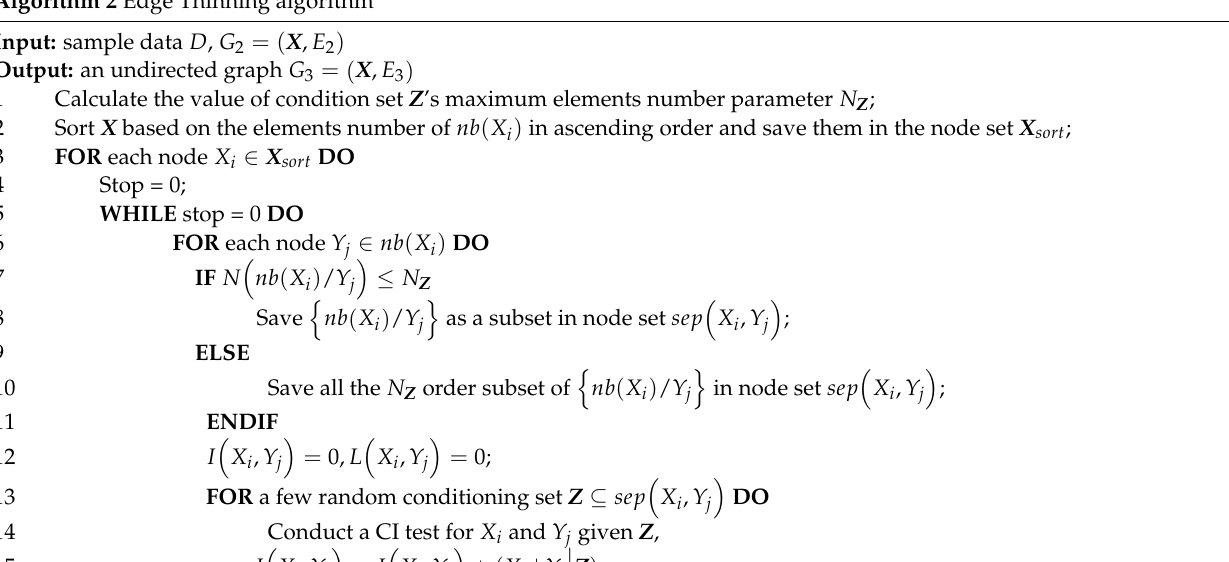
Algorithm 2 Edge Thinning